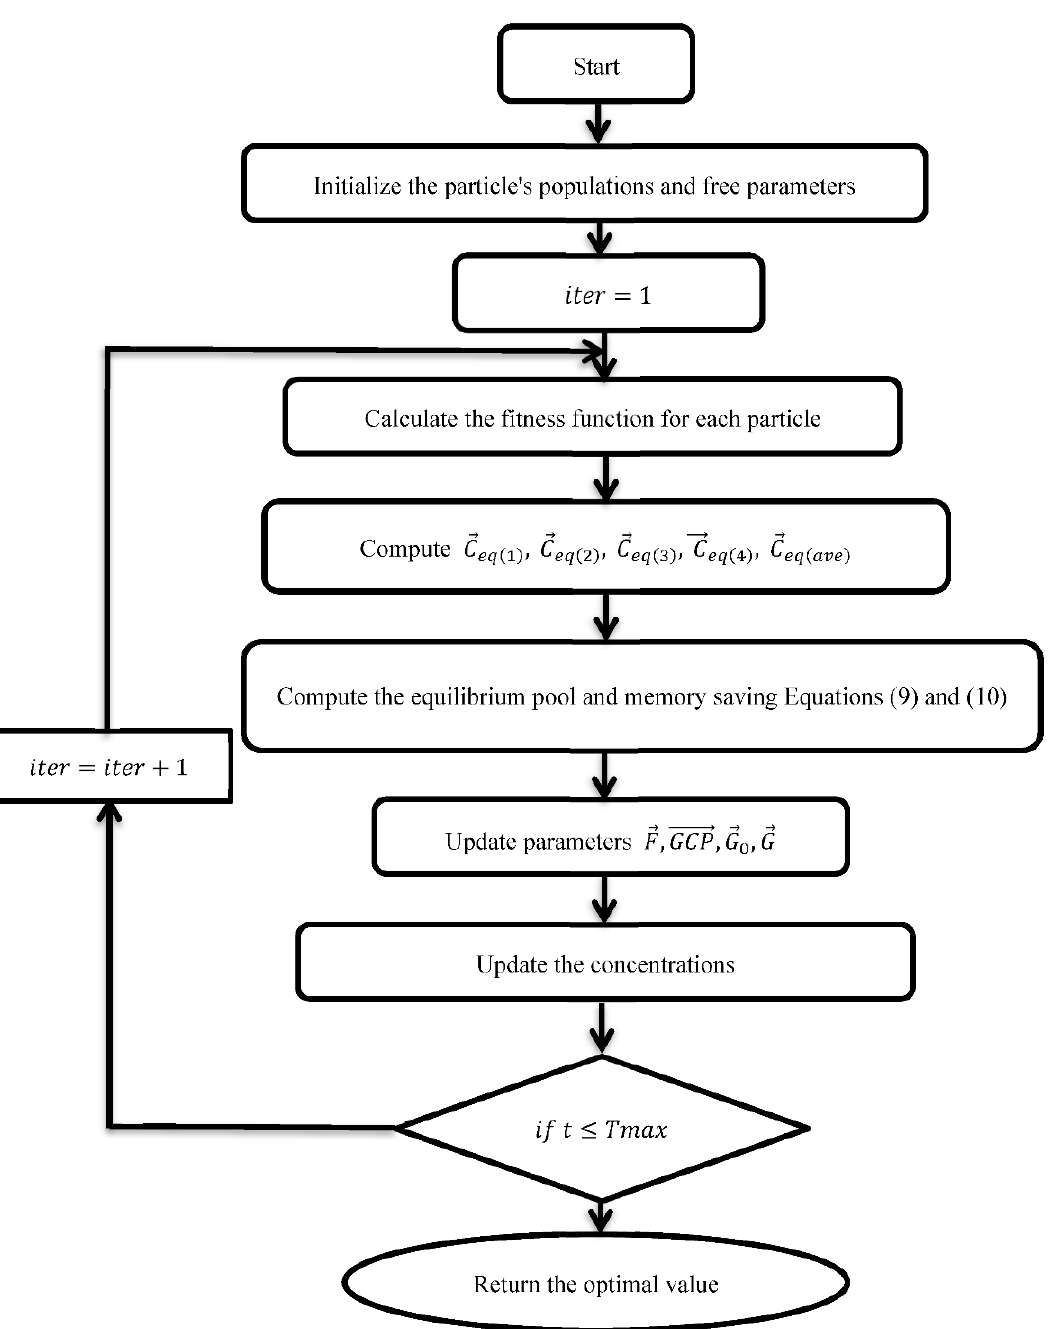
Figure 4. The flow chart of EO algorithm.